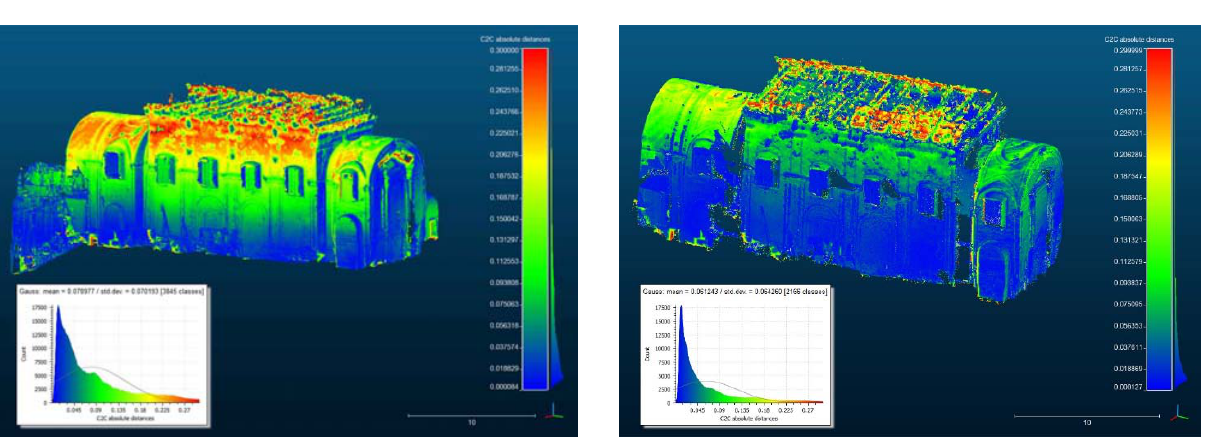
Figure 8: Results of the comparisons of point clouds in Cloud Compare: Faro Focus 3D s120 and Matterport Pro2 3D.